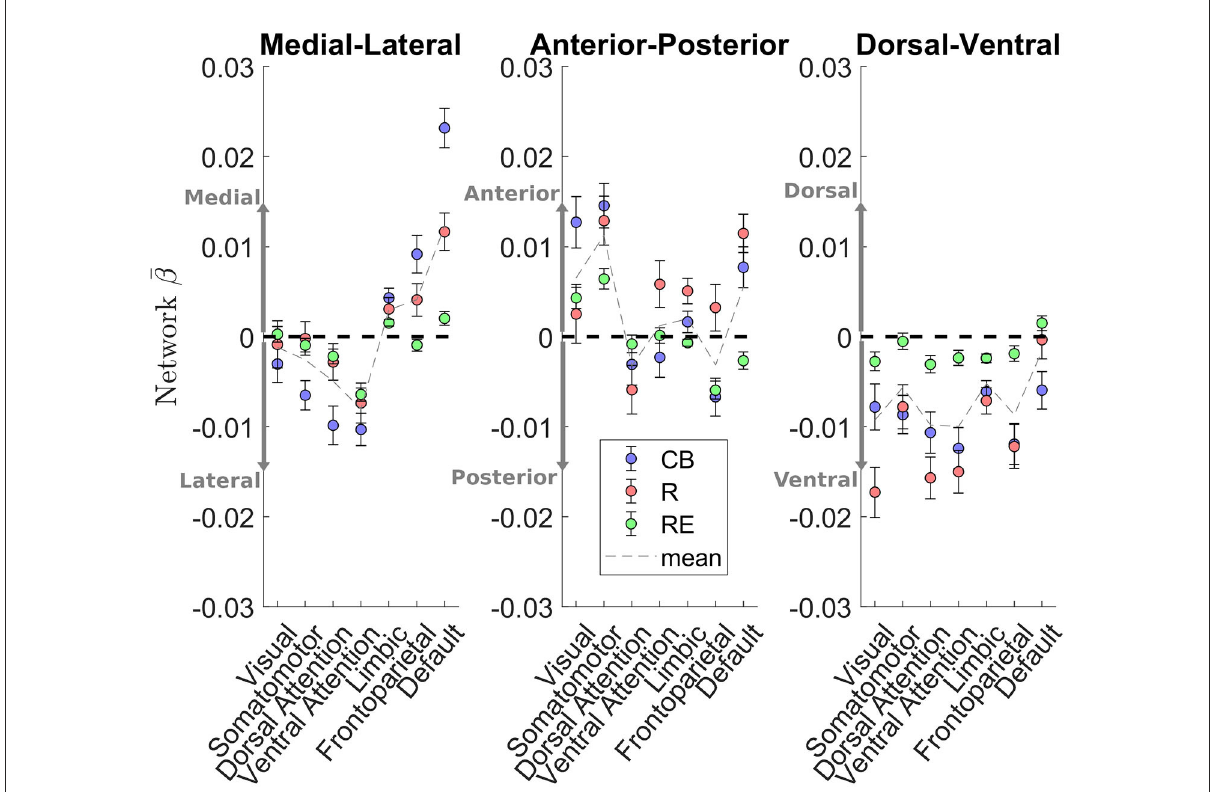
FIGURE3 Cortical network estimation of caudate connectivity gradient along the M-L, A-P, and D-V dimensions. The medial-lateral axis shows a clear distinction between default mode network preferring to connect along the medial aspect of the caudate, while the dorsal and ventral attention networks preferred to connect along the lateral aspect of the caudate. Visual and somatomotor networks seems preferentially connect to the anterior aspect of the caudate. The dorsal-ventral gradient does not show clear patterns of connectivity with the cortical